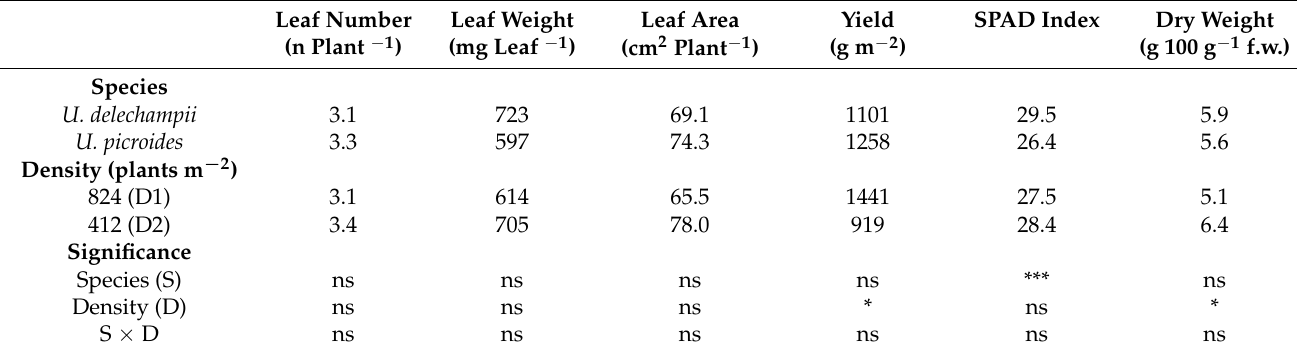
Table 1. Yield and physical traits of smooth golden fleece ( U. delechampii ) and prickly golden fleece ( U. picroides ) grown in a floating system at two sowing densities (first harvest).